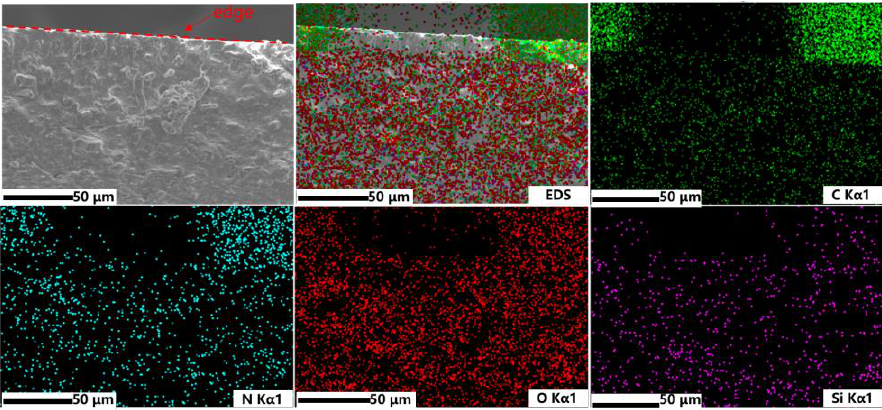
Figure 3. The EDS mapping result of C (green), N (blue), O (red), Al (purple) elements of cross- sectional ATH-90 SiR after NO 2 aging for 36 h.